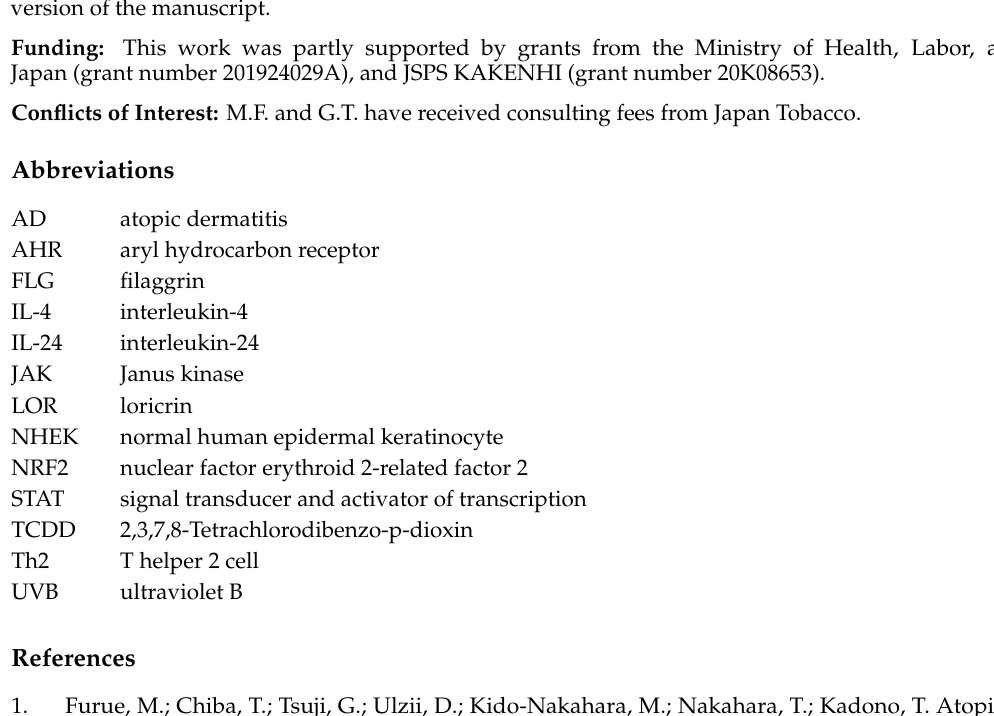
Supplementary Figure S1: Cell viability. Supplementary Figure S2: siRNA transfection Supplementary Figure S3: E ff ect of tapinarof on intracellular ROS production in NHEKs. Supplementary Figure S4: Tapinarof did not alter IL-20R1 and IL-20R2 mRNA expression and